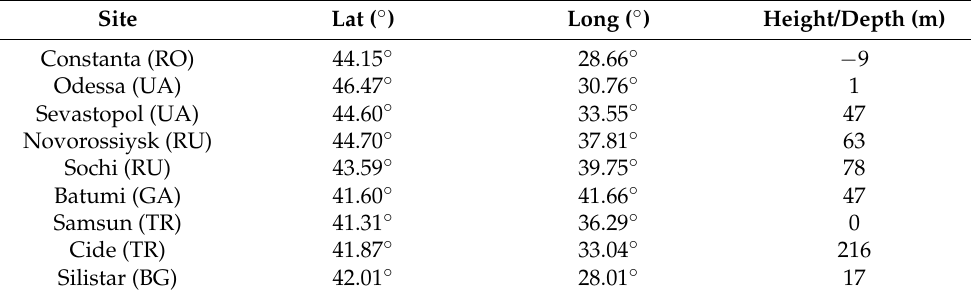
Figure 1. Black Sea target area including the reference points, where: 1—onshore; 2—alongshore; 3—offshore. Map processed from Google Earth, 2022. Table 1. Characteristics of the reference points located along the